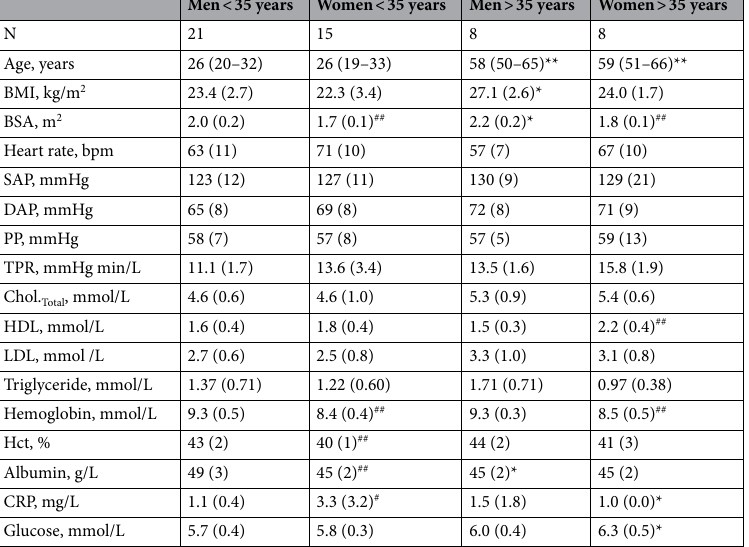
Table 1. Baseline characteristics for 36 healthy young and 16 healthy middle-aged subjects studied with CMR to determine the relationship of aortic distensibility to left ventricular diastolic function. * p < 0.05 and ** p < 0.01 vs. young of same gender; # p < 0.05 and ## p < 0.01 vs. different gender of similar